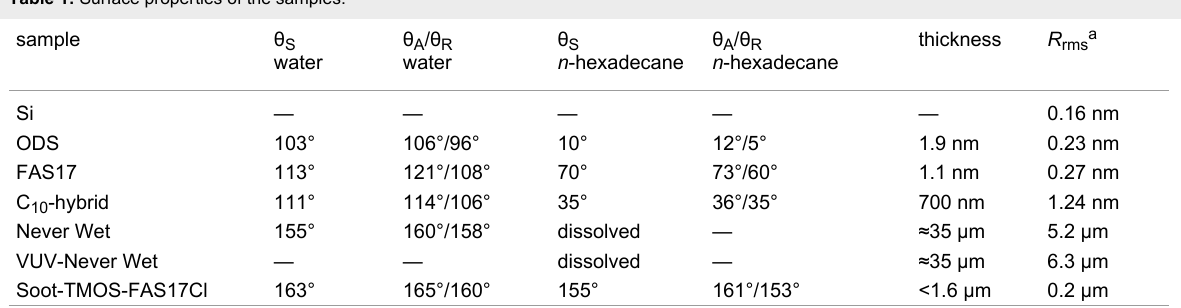
Table 1: Surface properties of the